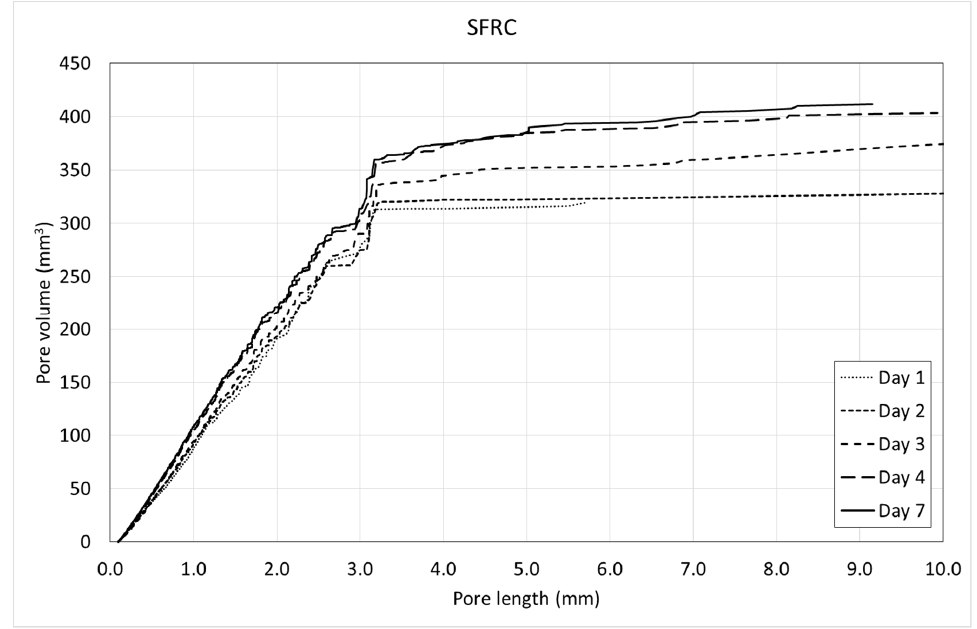
Figure 13. Pore volume curves of SFRC.